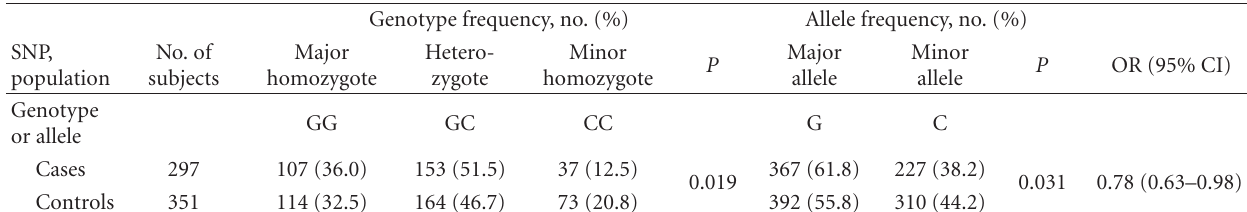
Table 1: Genotype and allele frequencies of IL-12b SNP rs6887695 in SLE cases and controls ∗ . Genotype frequency, no. (%)